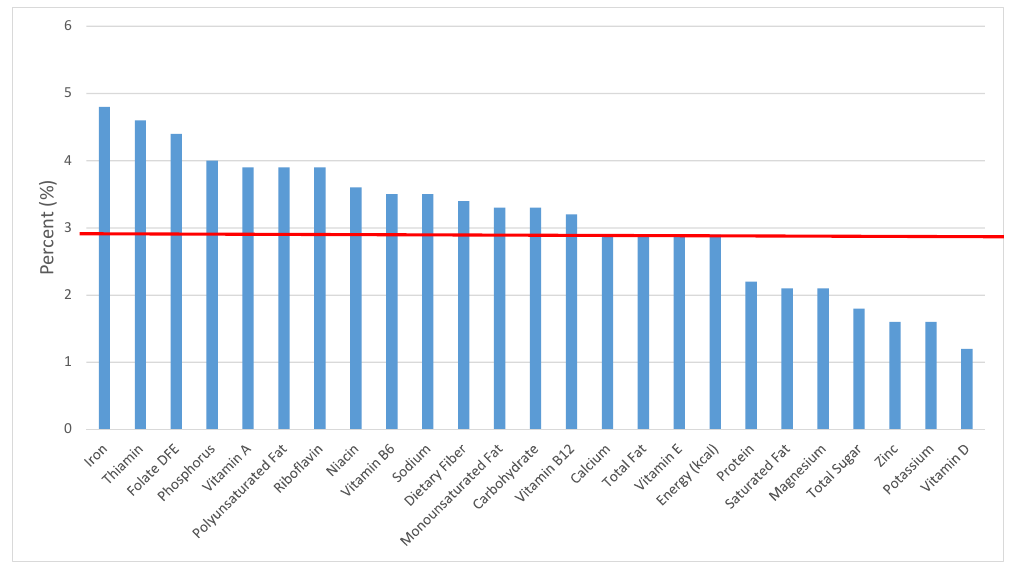
Figure 24. Quick breads and bread products as sources of energy and nutrients for children and adolescents 9–13 years old ( N = 1730, daily intake data): DFE = Dietary Folate Equivalents; solid red line represents percentage of energy (kcal) provided in the diet relative to nutrients—nutrients above the red line show the grain food’s contribution to nutrient density.